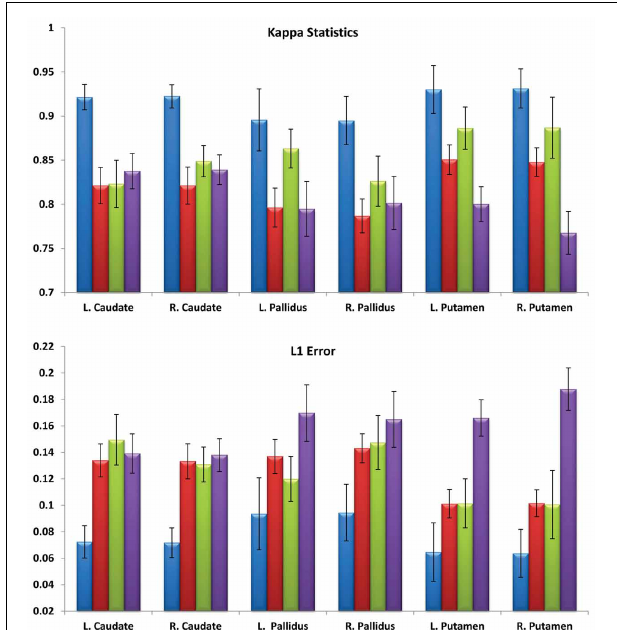
FIGURE 2 | Mean and standard deviation of mean Kappa statistics (top) and mean L 1 errors (bottom) for left and right pairs of caudate, putamen and pallidus in 30 subjects via four different segmentation methods: multi-atlas (blue), single-atlas (red), FSL (green), and FreeSurfer (purple).